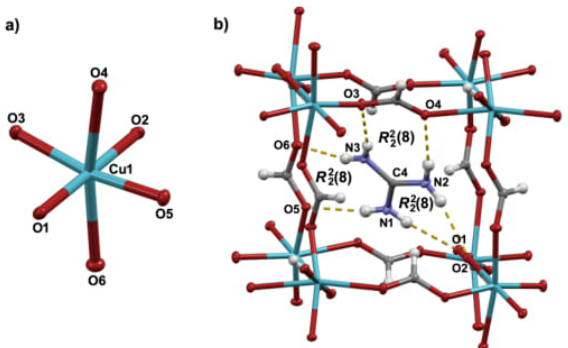
Figure 1. Mercury-ORTEP [34] POV-Ray [35] rendered view of ( a ) Jahn-Teller distorted octahedral environment of Cu 2+ cation in GuaCuF; ( b ) The guanidinium cation residing in the pseudo-cubic cavity whose size is determined by positions of eight bridged copper (II) ions. Guanidinium cation is anchored in the cavity by six hydrogen bonds. Ellipsoids are drawn at the 50% probability level while H-atoms are shown as spheres of arbitrary size. In ( b ) hydrogen bonds are presented by an array of yellow cylinders.